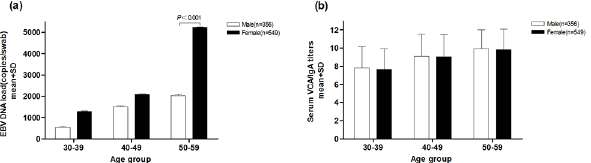
Fig 2. EBV load and VCA/IgA titers in males and females. Nasopharyngeal EBV load and serum VCA/IgA titers by gender and age groups. (a) Mean EBV load in females was higher than that of males by different age groups; EBV load increased with age in both genders. (b) There was no difference in VCA/IgA titers between males and females in different age groups; VCA/IgA titers increased with age in both males and females.